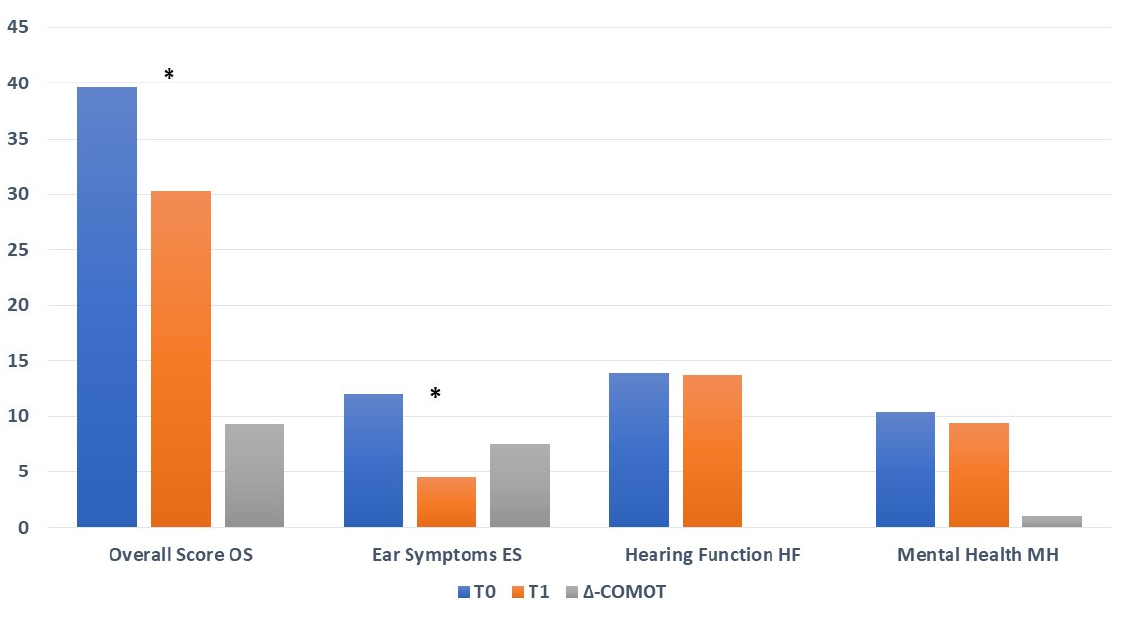
Figure 4. COMOT values for open techniques before surgery (T0) and twelve months later (T1); * statistically significant.